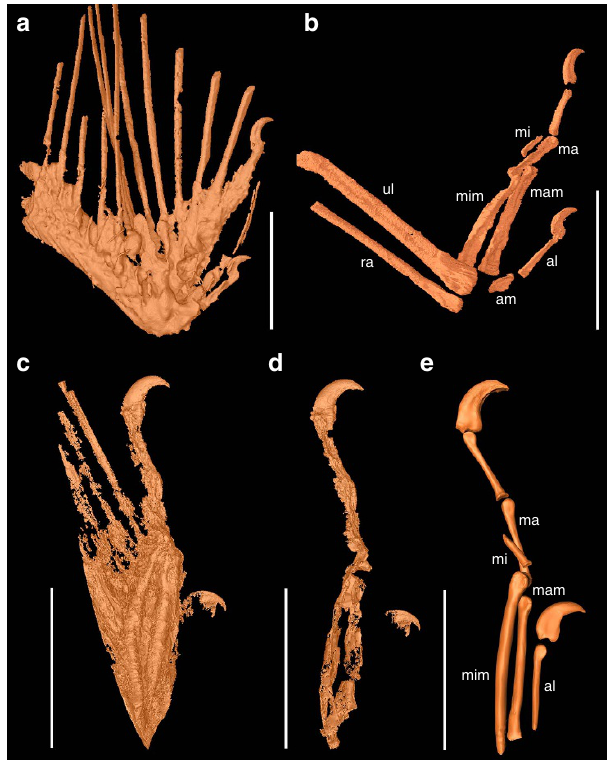
Figure 1 | SR X-ray l CTreconstructions of osteology in DIP-V-15100 and DIP-V-15101. ( a ) Mummified DIP-V-15100, showing rachises, skin, muscle and claws. ( b ) Skeletal morphology of DIP-V-15100, using different density threshold. ( c ) Mummified DIP-V-15101, showing rachises, skin, muscle and claws. ( d ) Skeletal morphology of DIP-V-15101. ( e ) Reconstruction of osteology based on the CT data. al, alular digit; am, alular metacarpal; ma, major digit; mam, major metacarpal; mi, minor digit; mim, minor metacarpal; ra, radius; ul, ulna. Scale bars, 5mm. NATURE COMMUNICATIONS|7:12089|DOI: